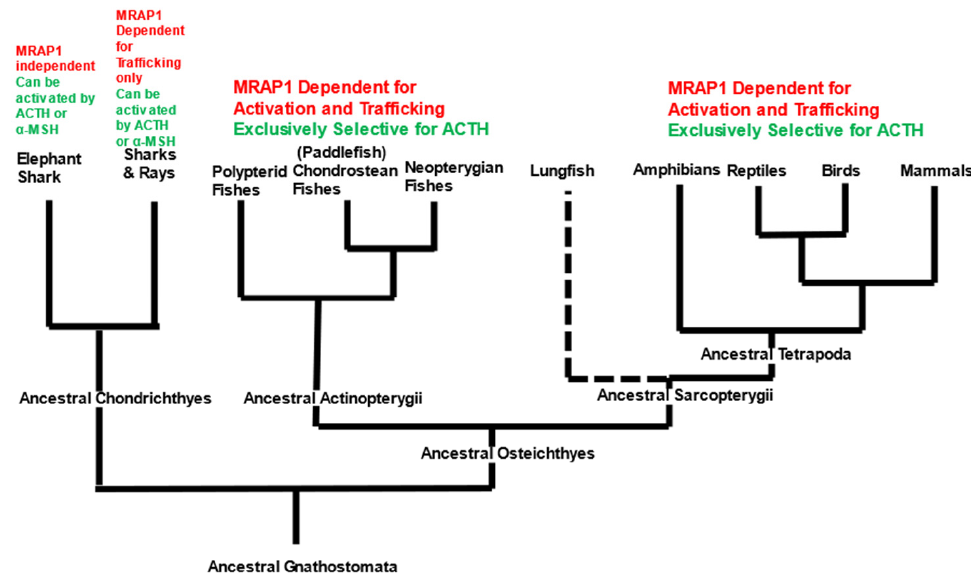
Figure 5. Summary of Mc2r activation requirements in gnathostomes. Definition of terms: Gnathos- tomata, is bilaterally symmetrical with a vertebral column and true hinged jaws; Osteichthyes, has bony vertebral column; Sarcopterygii, all bony vertebrates with lobed fins or limbs; Actinopterygii, all bony fishes with ray fins; Tetrapoda, all vertebrates with four limbs; Chondrichthyes, gnathostomes with a cartilaginous vertebral column. Dashed line highlights that functional studies have not been performed on the Mc2r ortholog of the basal Sarcopterygian lineages, such as the lungfishes. For the tetrapods, the first function of Mrap1 is to facilitate the trafficking of the Mc2r ortholog from the endoplasmic reticulum to the plasma membrane [2,3]. Once